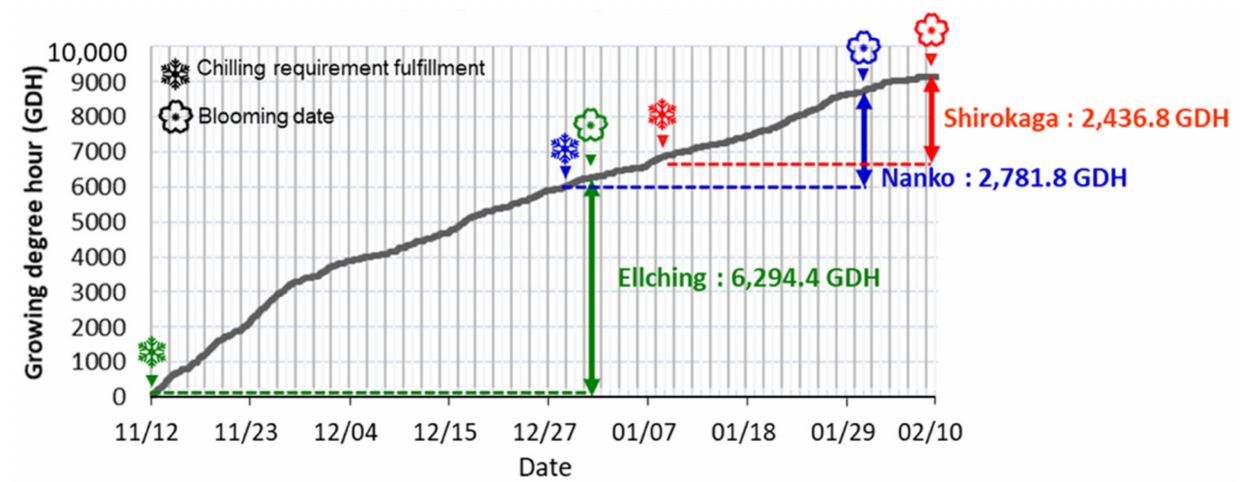
Figure 4. Evaluation of the HR of three cultivars using the growing degree hour (GDH) model. ‘Nanko’, high chill; ‘Shirokaga’, extra high chill; ‘Ellching’, low chill. Ice crystal mark means chilling requirement fulfillment; flower mark means blooming date.